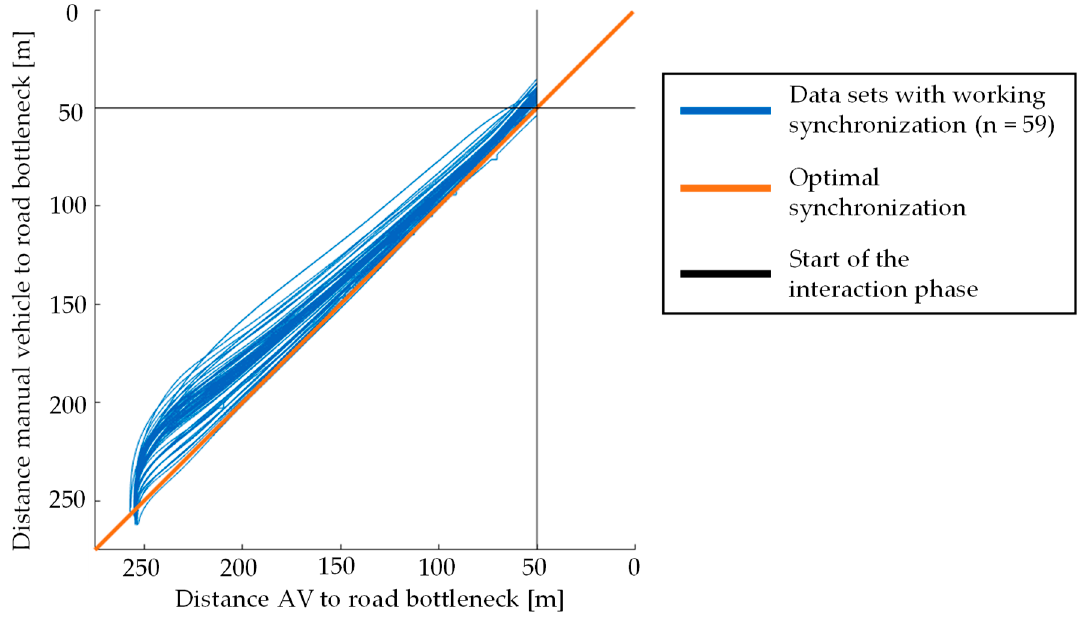
Figure 12. Distances of the manual vehicles plotted over the distances of the AVs to the bottleneck during the detail synchronization phase. The angle bisector visualizes the distances for an ideal synchronization.